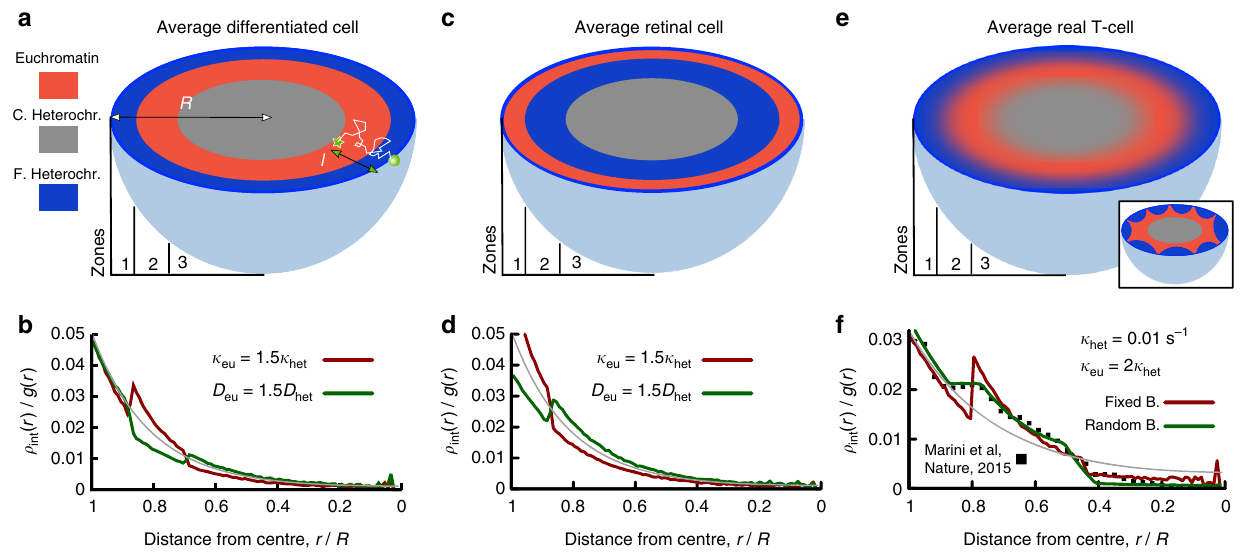
Fig. 5 HIV integration hot-spots are affected by nuclear organisation. a , c , e Different cell lines display different chromatin organisations at the nuclear scale. a Shows a typical differentiated cells, modelled as a sphere with 3 concentric shells of equal volume. Zones 1 and 3 are populated by facultative and constitutive heterochromatin, respectively. Zone 2, the middle layer, is populated by euchromatin. This con fi guration may be viewed as an angularly averaged model and it is appropriate to study HIV integration in population averages. c Shows the model for a ‘ retinal ’ cell, where the two outer layers are inverted 64 . e Shows the model for a realistic population of T-cells (typical con fi guration of a single cell is shown in the inset). Here the location of the boundaries between zones 1 and 2, and between zones 2 and 3, is varied to account for local density variations and cell-to-cell fl uctuations (see text). b , d , f Nuclear distribution of HIV integration sites in b differentiated cells, d retinal cells and f T-cells. The result with uniform D and κ (yielding l ≃ 2.23 μ m) is shown in grey in each panel. The number of integrations at distance r , ρ int ( r ), is divided by the area of the shell, g ( r ) = 4 π r 2 dr , and normalised to unity. Filled squares in f denote data from ref. 66 . Source data are provided as a Source Data fi